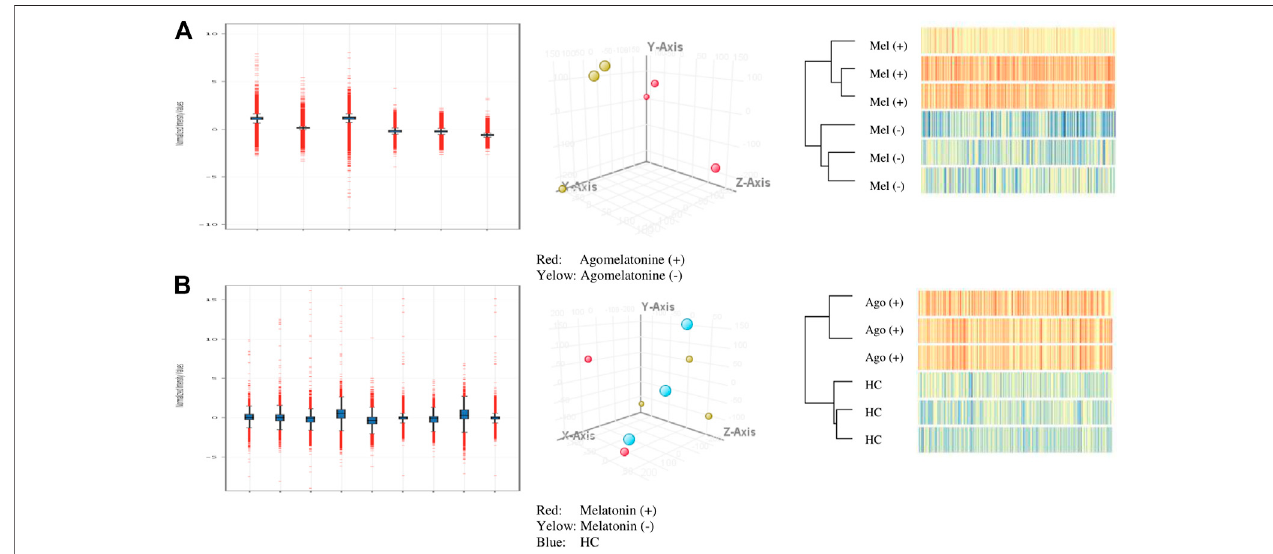
FIGURE 1 | Quality control for analyzed A-cell culture and B-clinical model (normalized intensity value; PCA fi ltered on fl ags [detected, not detected]; hierarchical clustering).